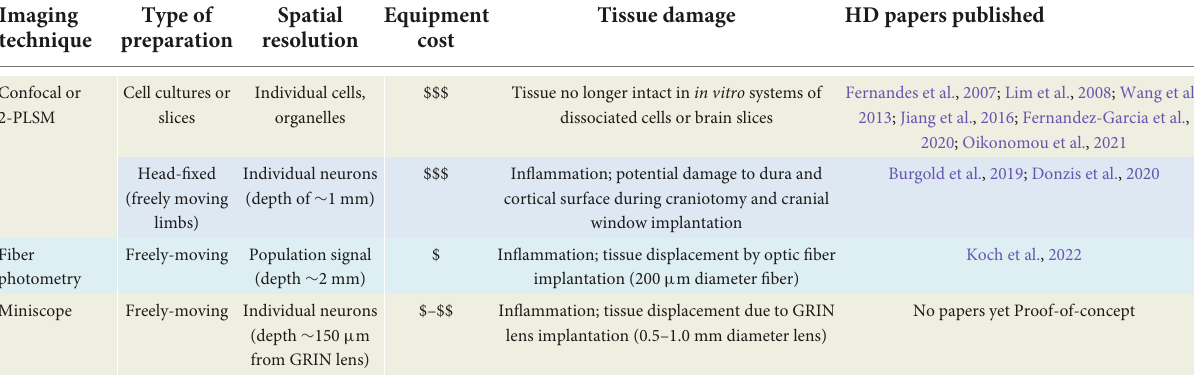
TABLE 1 Ca 2 + imaging methods applied to the study of Huntington’s disease. Imaging